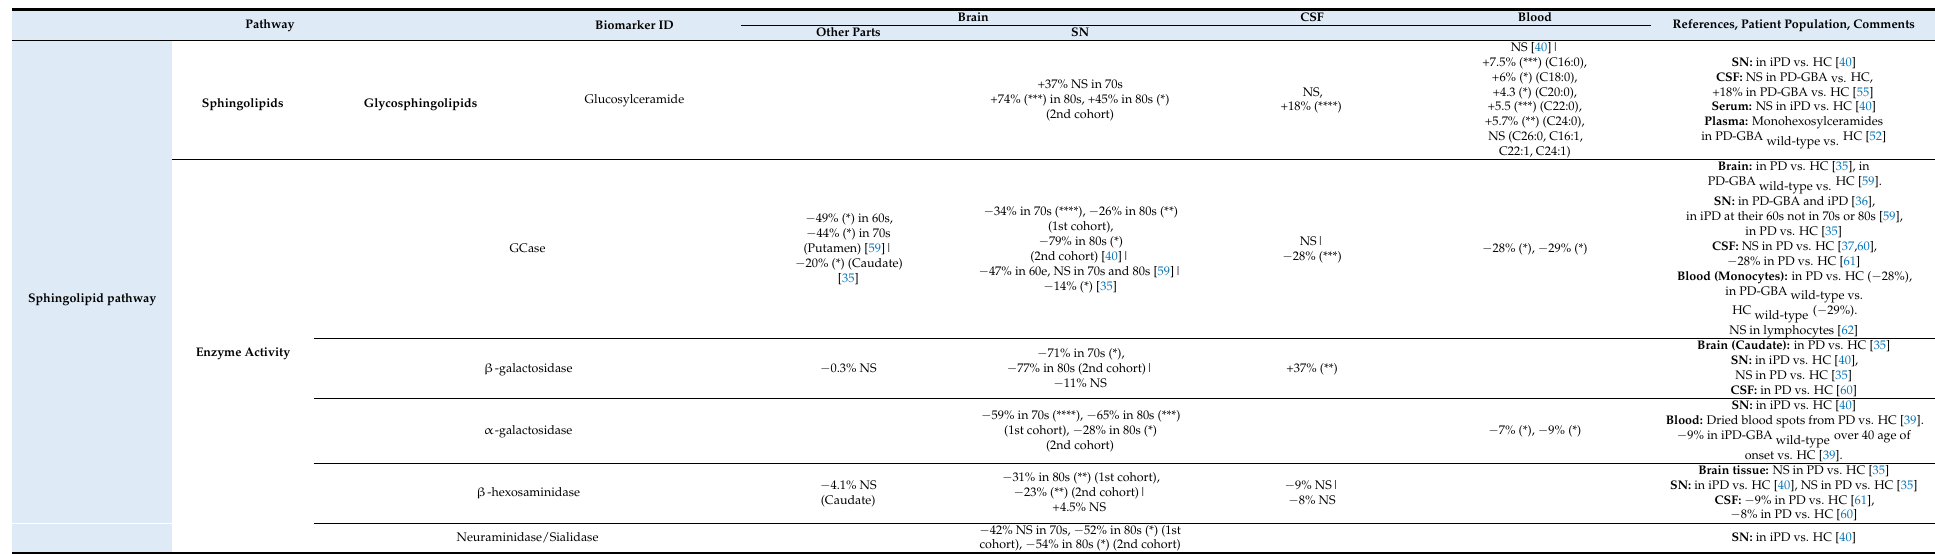
Table legend: This table lists percentage changes of the sphingolipid pathway lipids and enzymes in the PD brain that are also measured in CSF and/or blood. The percentages are either reported by authors or calculated by considering the mean/median value of control data as the initial value. The percentage changes are increased (+) or decreased ( − ) metabolites levels in the PD cases compared to controls. The degree of significance is retrieved from sources. Abbreviations: HC: healthy control; PD: Parkinson’s Disease; PD-GBA: PD patients with GBA mutations; CSF: cerebrospinal fluid; SN: substantia nigra; OC: occipital cortex; GBA: Glucosylceramidase Beta1; |: separating data from different studies. (NS: non-significant; * p <